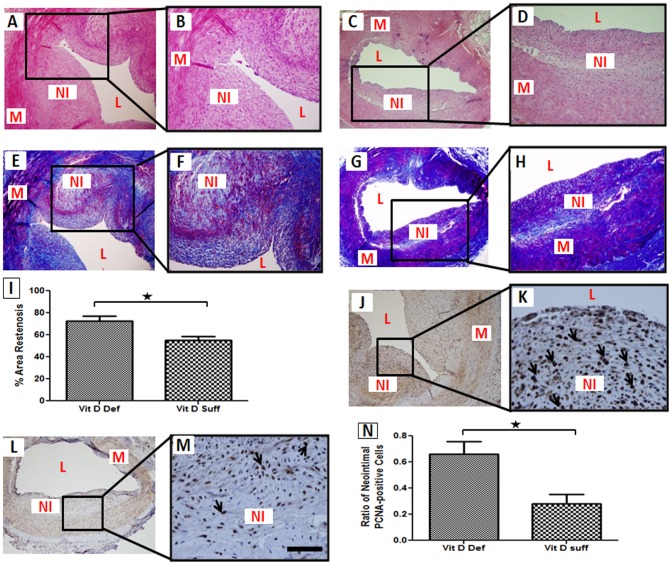
Effect of vitamin D deficiency on the development of restenosis following balloon angioplasty.Paraffin embedded thin sections were cut, deparaffinized and stained with H&E and Masson's trichrome stain and immunohistochemical examination was done for proliferating cell nuclear antigen (PCNA). For immunohistochemistry, sections were stained with DAB as chromogen and counterstained using hematoxylin. H&E staining shows the magnitude of neointimal formation in vitamin D-deficient hypercholesterolemic group (A–B) compared to vitamin D-sufficient hypercholesterolemic group (C–D). Masson's trichrome staining show increased smooth muscle cells and extracellular matrix material in neointimal tissue of vitamin D-deficient hypercholesterolemic group (E–F) compared to vitamin D-sufficient hypercholesterolemic group (G–H). Percent area restenosis was calculated by NIH image J as described under “Material and Methods” (I). Expression of PCNA in thin sections of post-balloon angioplasty coronary arteries from vitamin D-deficient hypercholesterolemic (J–K) and vitamin D-sufficient hypercholesterolemic (L–M) swine is shown. Arrows indicate cells expressing PCNA. The bar graph shows the quantitative analysis of the PCNA-positive cells counted in 5 randomly selected fields of the immunostained sections of the post-angioplasty vitamin D-deficient and vitamin D-sufficient swine coronary arteries (N). Data are shown as mean ± SEM. (N = 8) *P<0.5. Scale bar 100 µm, magnification (100×–600×); L: lumen, M: medial layer, NI: neointima.